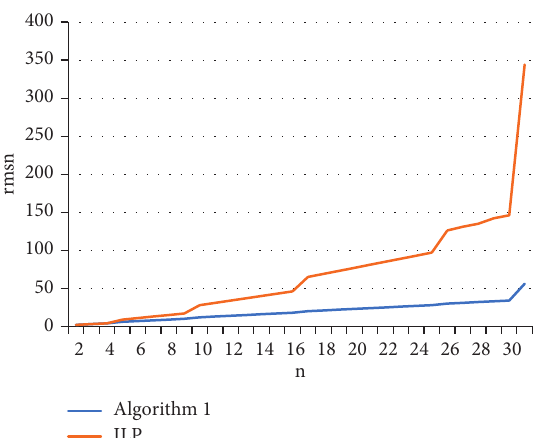
Figure 3: Comparison between standard radio mean square number, algorithm, and integer linear programming for the upper bound of radio mean square number for the path graph.